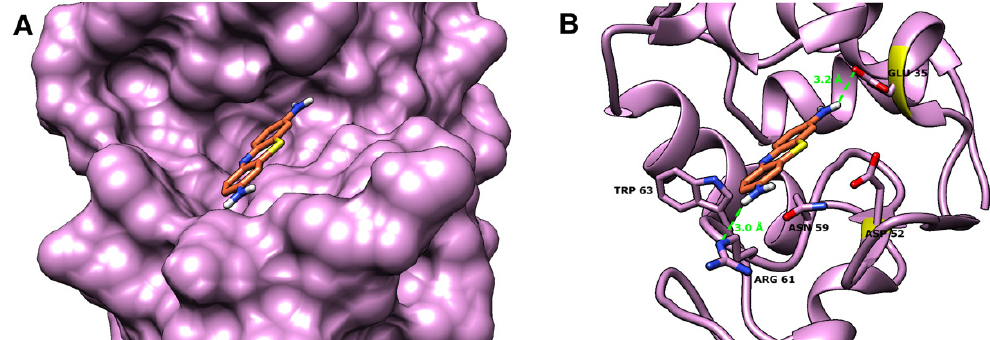
Figure 8. The predicted binding mode of thionine acetate with the hen egg white lysozyme (PDB 2VB1 [47]). The enzyme is shown in pink as ( A ) a surface representation of the binding site and ( B ) a cartoon representation showing the amino acid residues (as sticks) located in the active site close to the inhibitor. The inhibitor is shown as orange sticks. The predicted hydrogen bonding interactions are shown as green dashes with distances in Å.